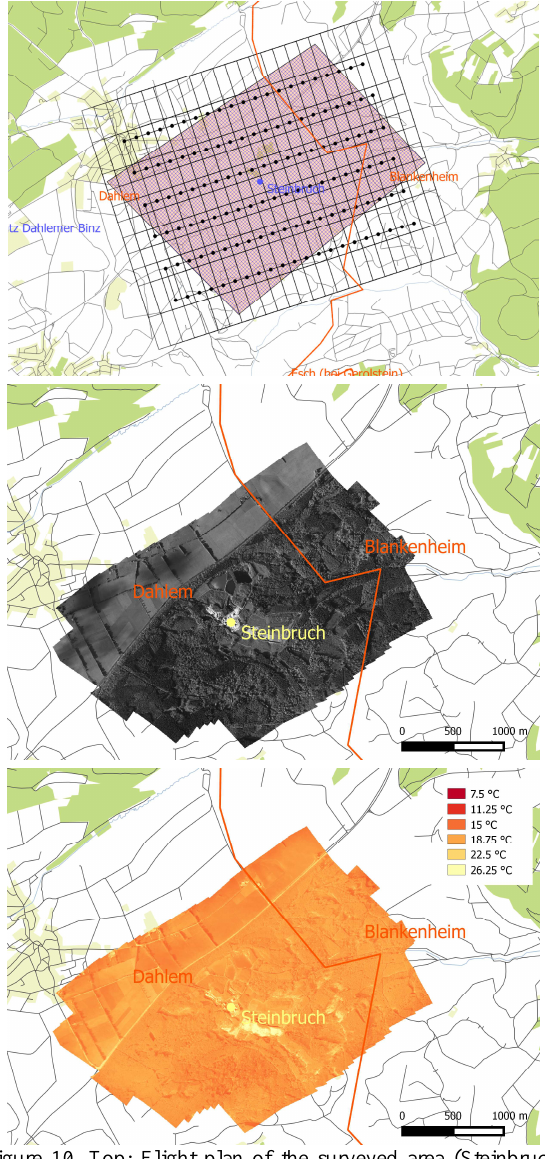
Figure 10. Top: Flight plan of the surveyed area (Steinbruch, Schmidtheim Eifel). Middle: Georeferenced orthomosaic of the panchromatic channel. Bottom: Visualization of the orthomosaic TIR image layer. Both mosaics were rendered with a SfM tool (Agisoft PhotoScan) and then imported in QGIS.